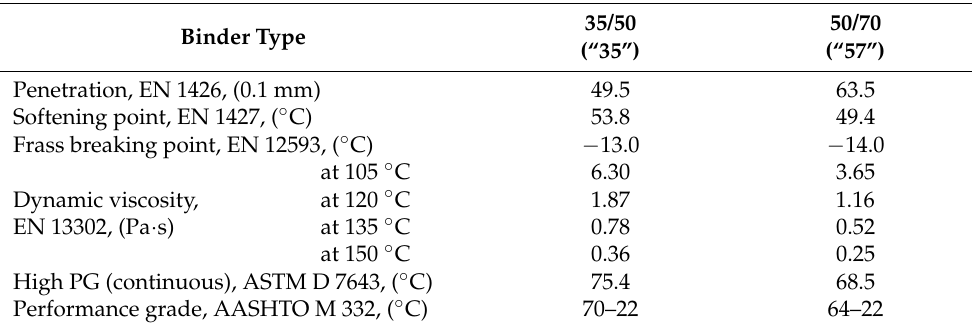
Table 1. Characterization of the reference 35/50 and 50/70 road-paving bitumen used as a base for the investigated binders.